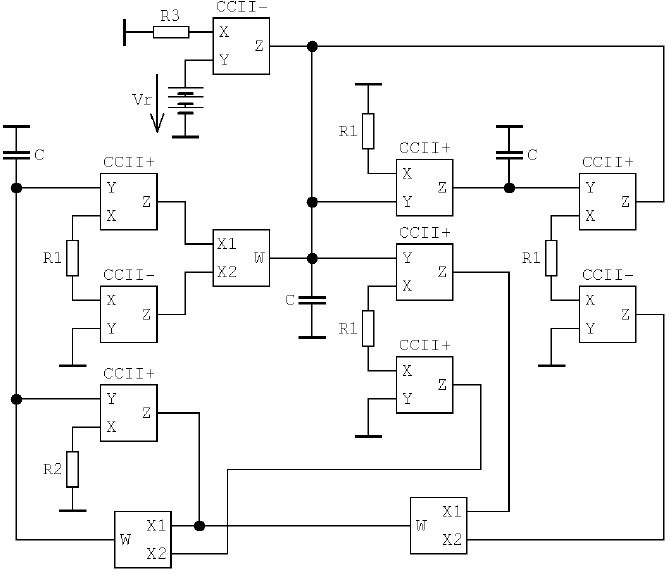
Figure 7. Realization of the discovered chaotic dynamical system, current-mode equivalent circuit.